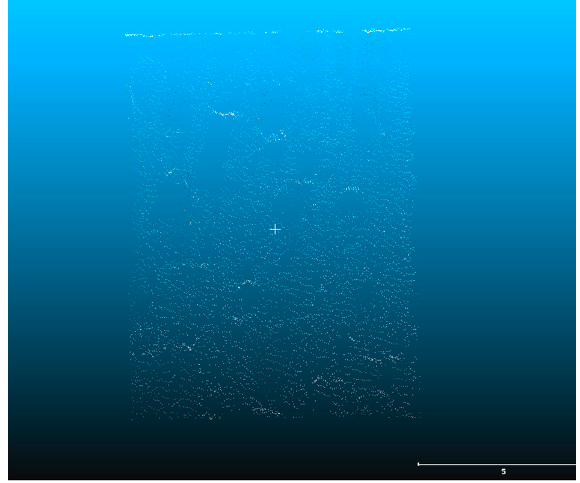
Figure 23. UAV Nadir in Pix4D.